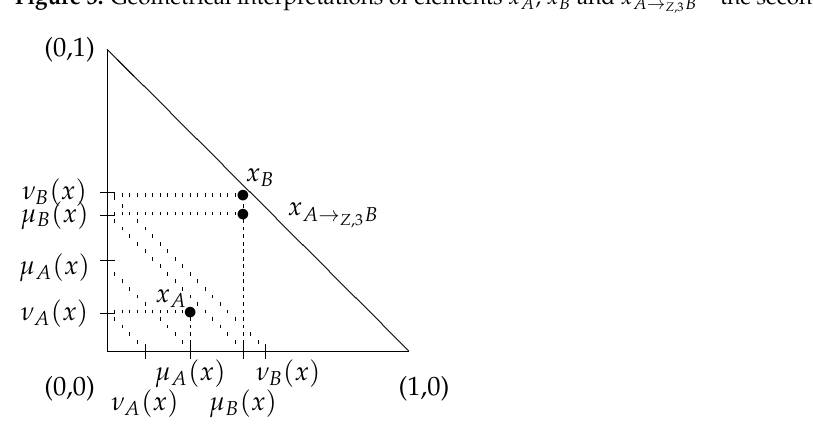
Figure 4. Geometrical interpretations of elements x A , x B and x A